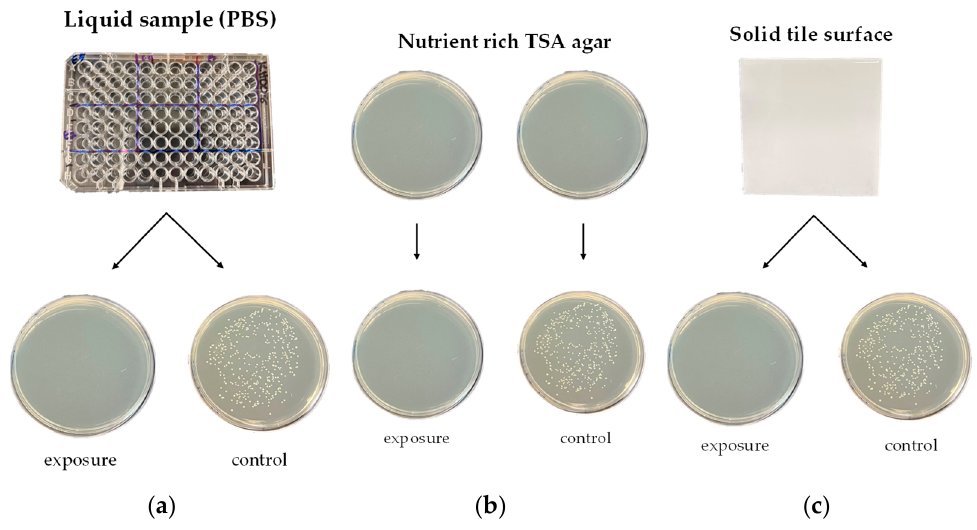
Figure 2. Three different growth environments tested in this study. ( a ) Liquid sample (PBS), ( b ) nutrient-rich TSA agar, and ( c ) solid tile surface.